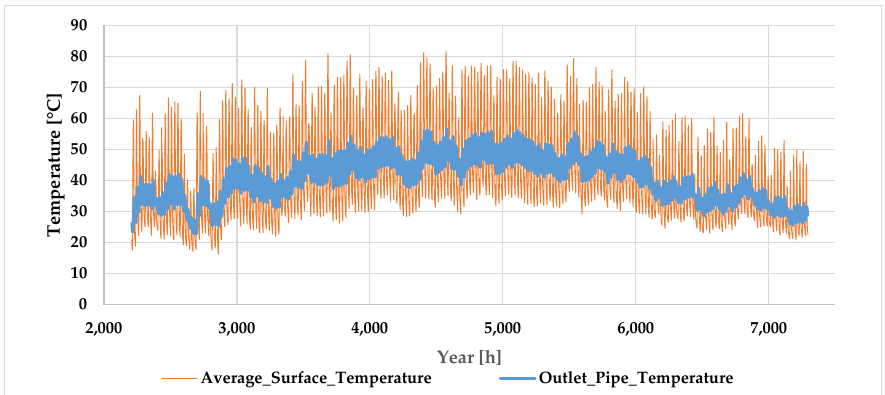
Figure 10. Temperature trend of the surface pavement and at the depth where the pipeline is located without the RTC system.